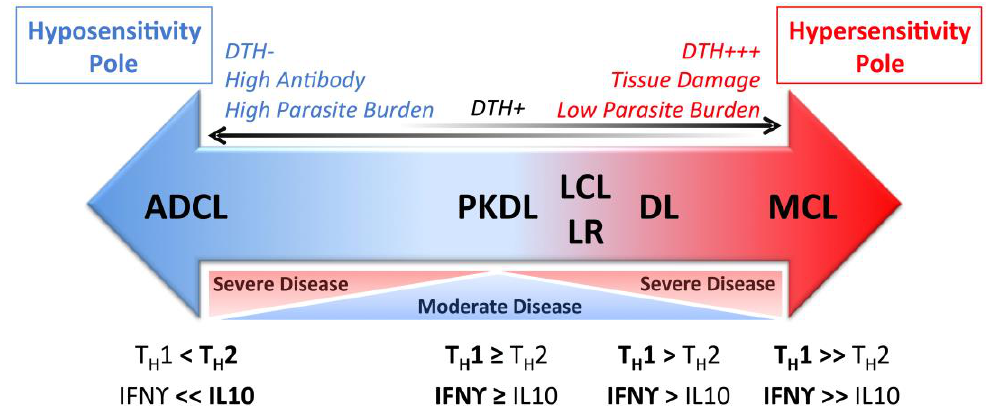
Figure 2. Schematic representation of the spectrum of human cutaneous leishmaniasis manifestations. The localized disease LCL results in the presence of an IFN γ -dominated response, detected by DTH response and T cells. In MCL, T cell responsiveness to Leishmania antigen further increases towards the hypersensitivity pole, resulting in tissue damage but low parasite burden. The opposite polar responses with low or absent T cell responsiveness, high parasite burden and antibody titers culminate in ADCL. ADCL: Anergic diffuse cutaneous leishmaniasis; PKDL: Post Kala-Azar dermal leishmaniasis; LCL: Localized cutaneous leishmaniasis; LR: Leishmania recidivans; DL: Disseminated leishmaniasis; MCL: Mucocutaneous leishmaniasis; DTH: Delayed type 1 hypersensitivity; T H : T helper cell; T H 1: T H 1-type immune response; T H 2: T H 2-type immune response; IFN γ : Interferon gamma; IL-10: Interleukin 10.